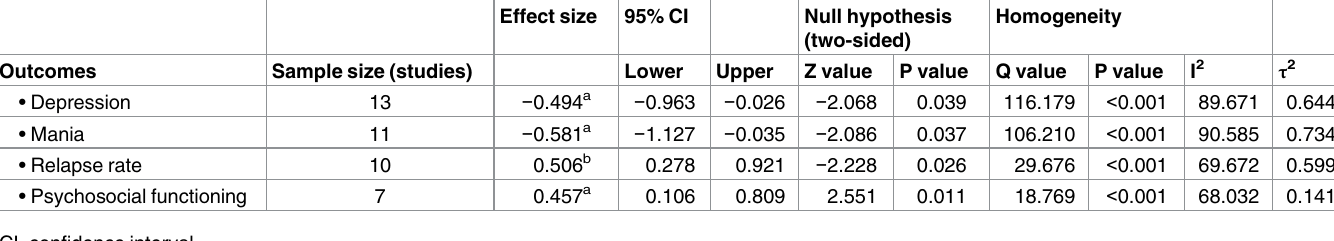
Table 2. Overall effect size of cognitive behavioral therapy for patients with bipolar